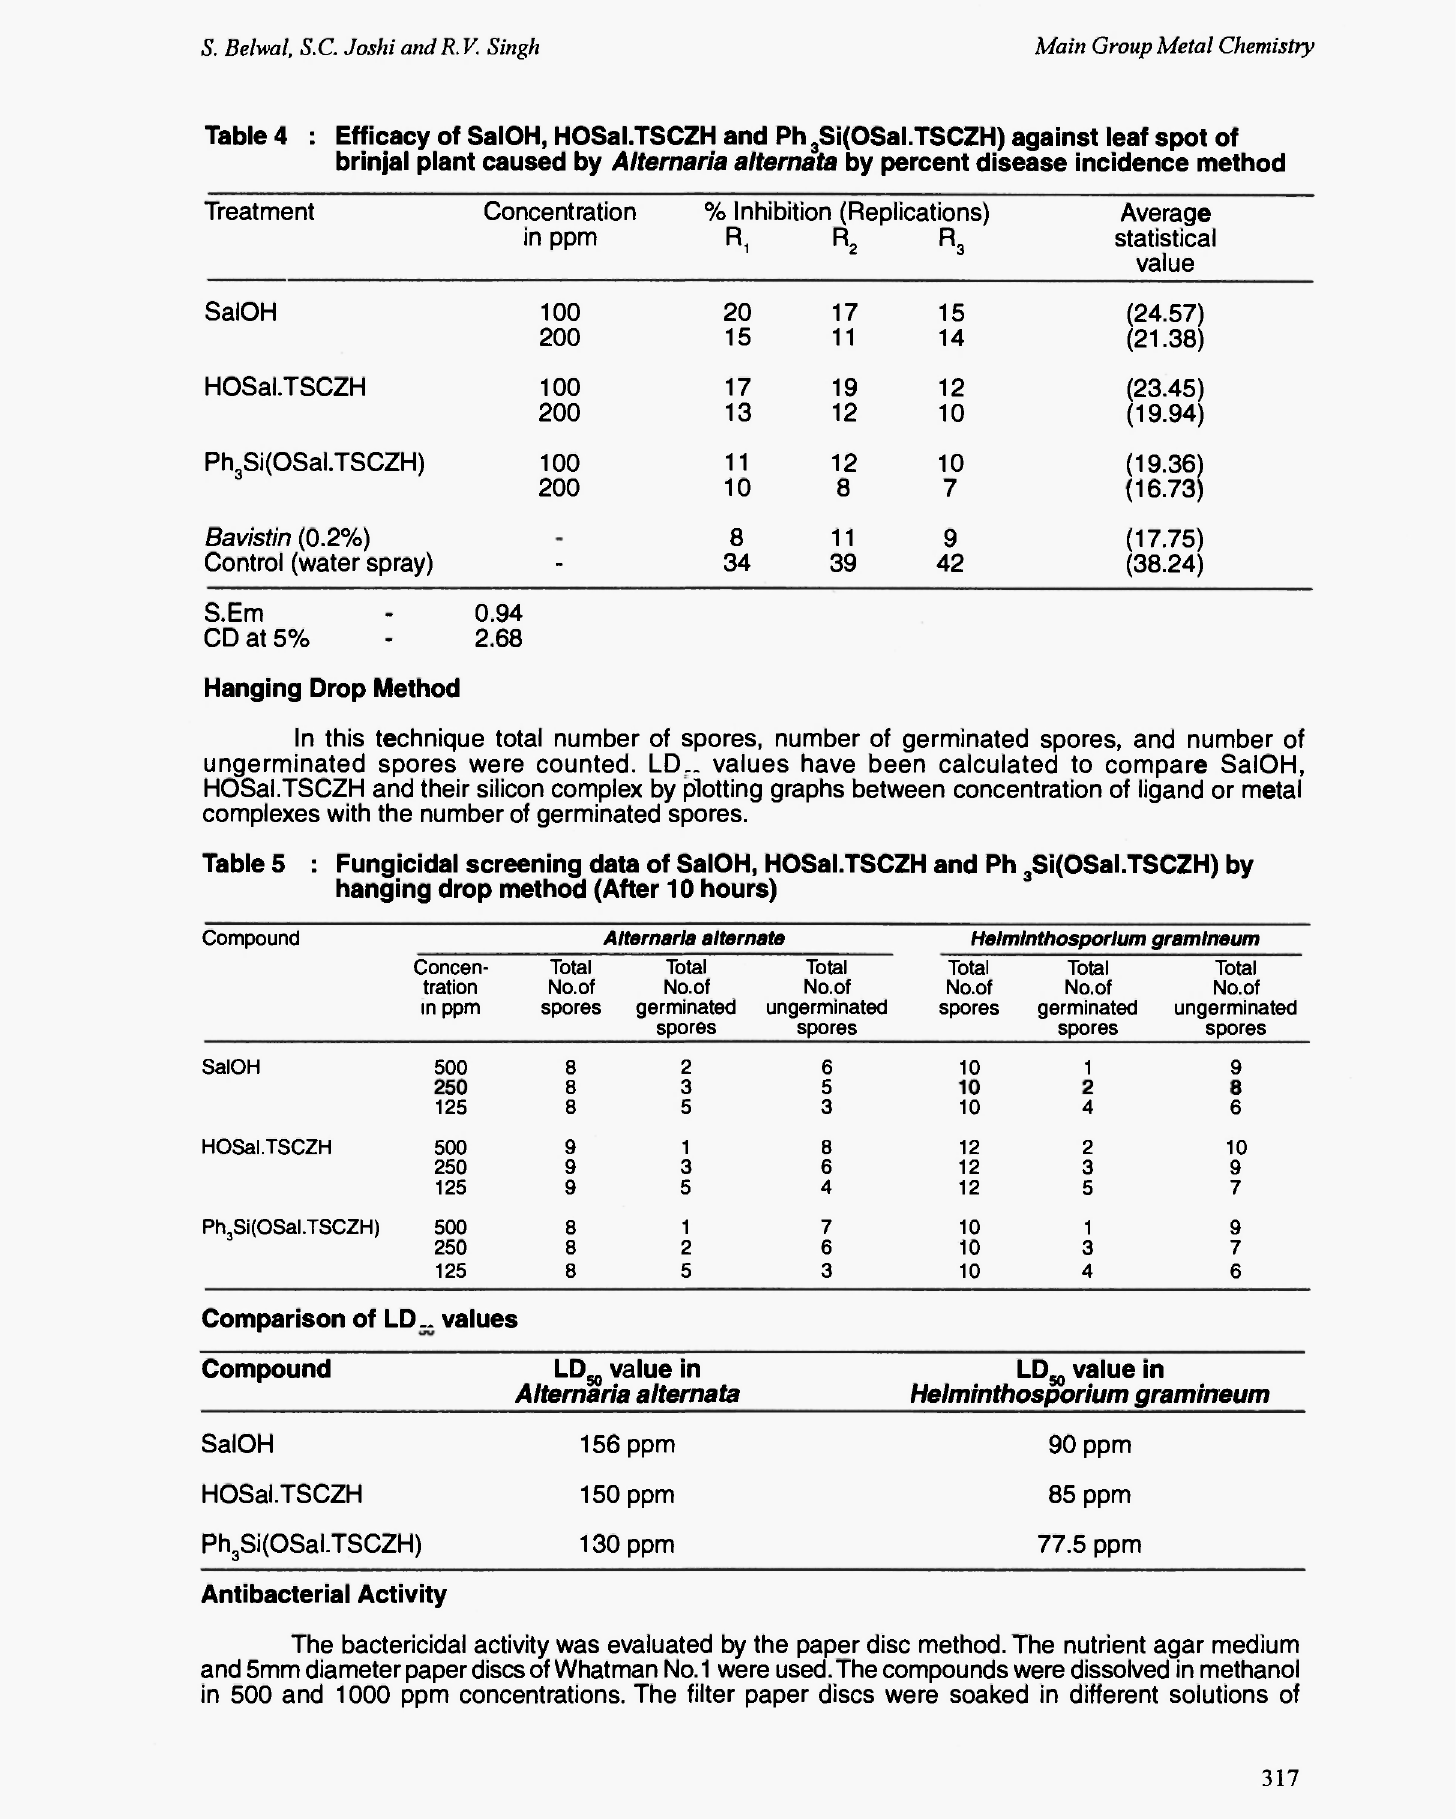
Si(OSal.TSCZH) against leaf spot of 3